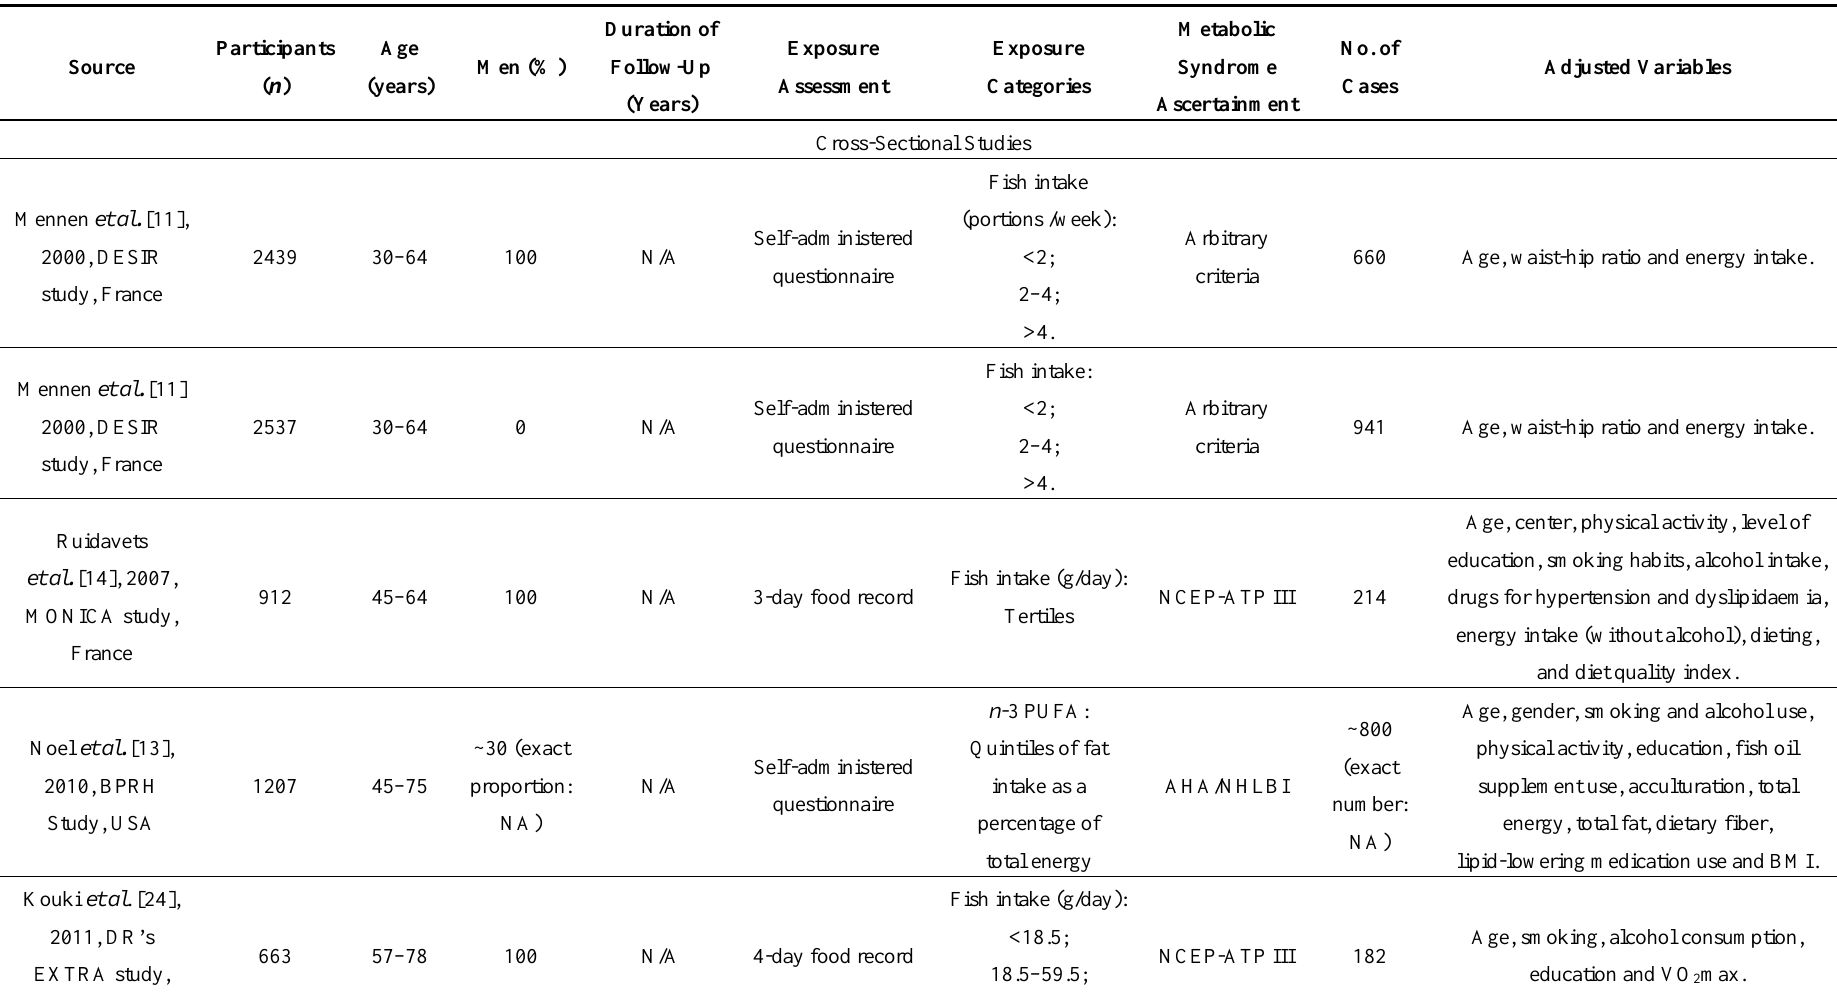
Table 1. Characteristics of included cross-sectional studies and prospective cohort studies on the associations between intakes of fish or LCω3PUFA and risk of metabolic